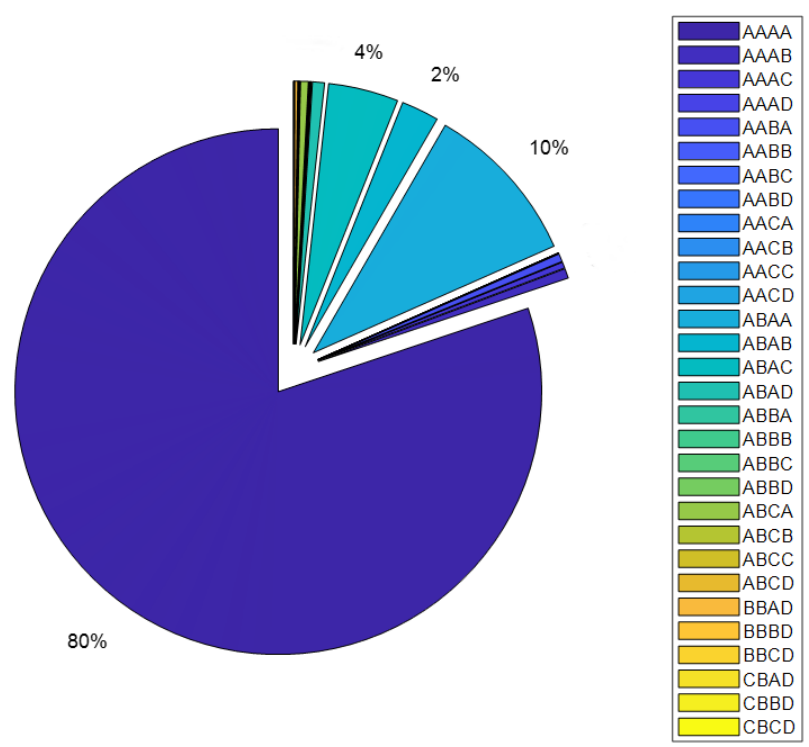
Figure 4. The distribution of number of customers per each class.